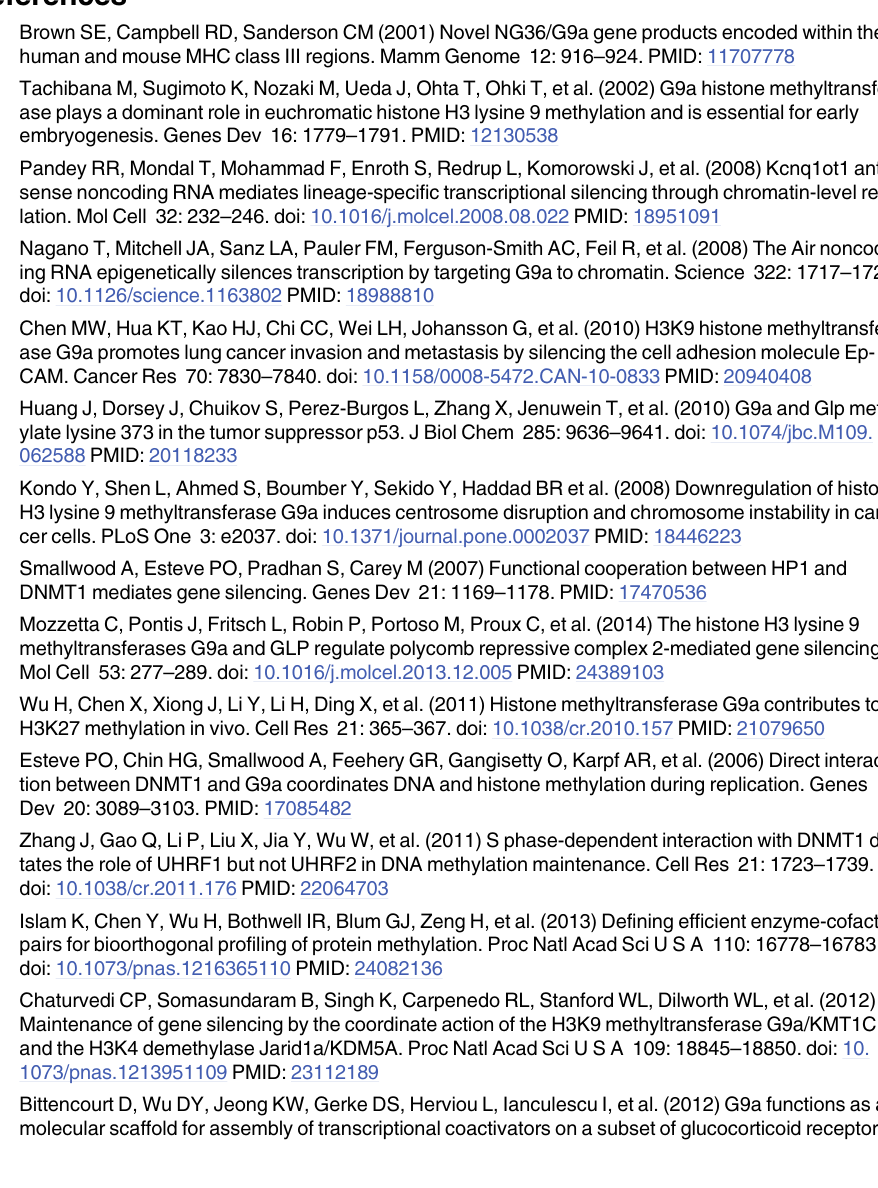
S1 Table. Real-time RT-PCR